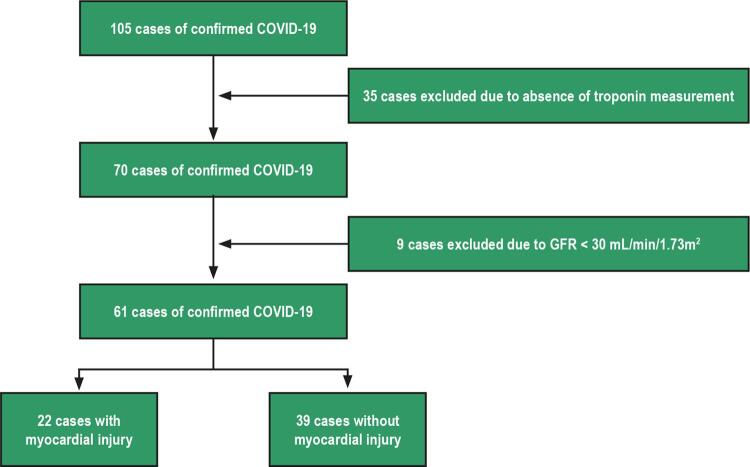
– Flowchart for recruiting patients.